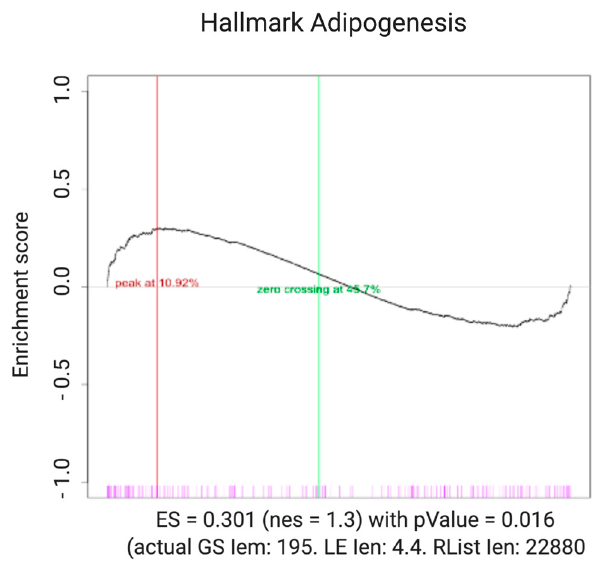
Figure 3. GSEA Enrichment plot (KEGG pathways) for Adipogenesis. Adipogenic signaling pathways are positively enriched in the arrhythmogenic right ventricular cardiomyopathy (ARVC) dataset for which genes belonging to the canonical adipogenic pathways (HALLMAK_ADIPOGENIC gene set) were analyzed. The black curve corresponds to the enrichment score (ES), which is the running sum of the weighted enrichment score obtained from GSEA software with the normalized enrichment score (NES) and specified p -value.